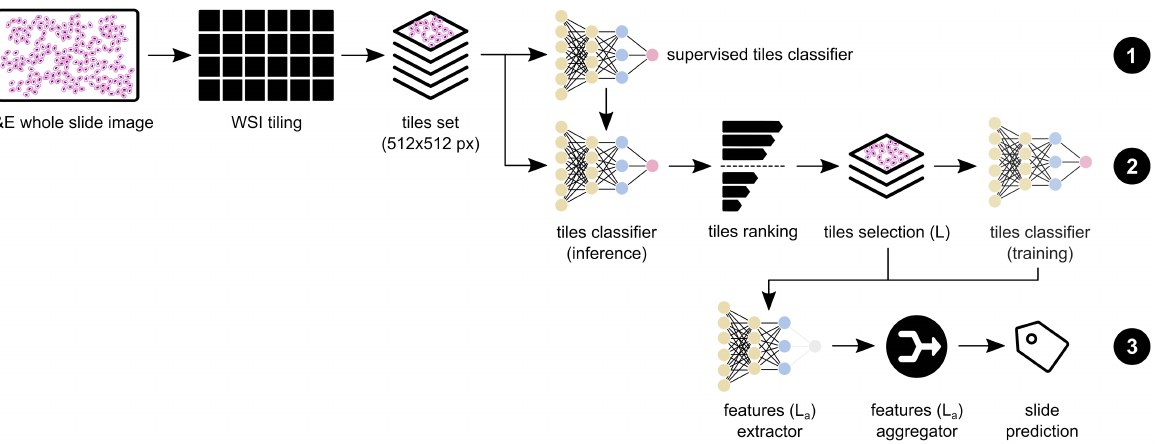
Figure 3. Proposed workflow for colorectal cancer diagnosis on whole-slide images, as a three-step method: (1) supervised tile classifier, using the annotated slides set; (2) weakly supervised tile classifier (initialised with the supervised weights), selecting the most relevant tiles by ranking by the expected values; and (3) whole-slide prediction by aggregating the features (obtained with the previous CNN model) extracted from the most relevant